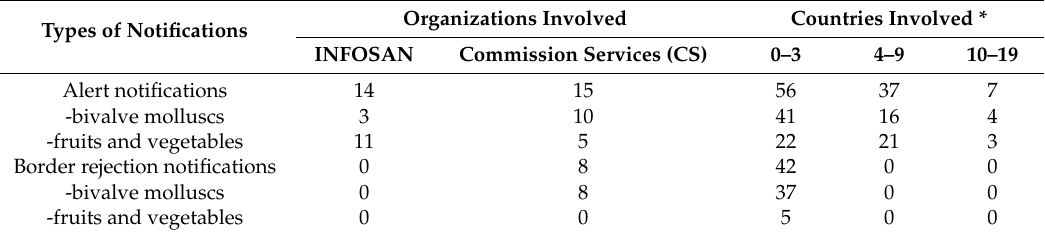
Table 2. Countries/Organizations involved in alert and border rejection notifications * implicating “norovirus” in the two food product categories under examination from 1979 until 31 August 2017 in the EU RASFF